Question: How would you classify this visualization?
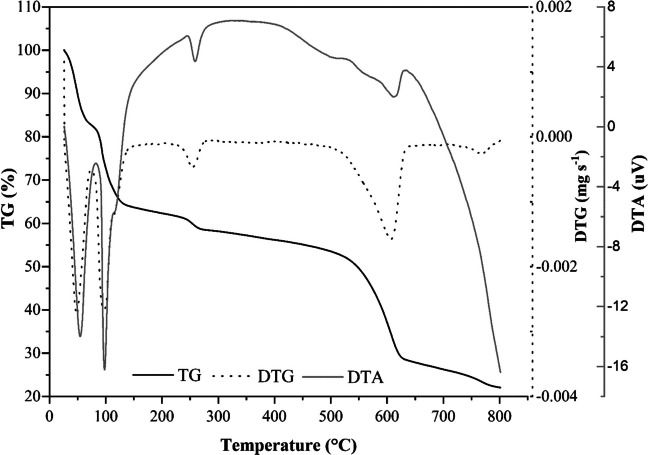
Answer: line